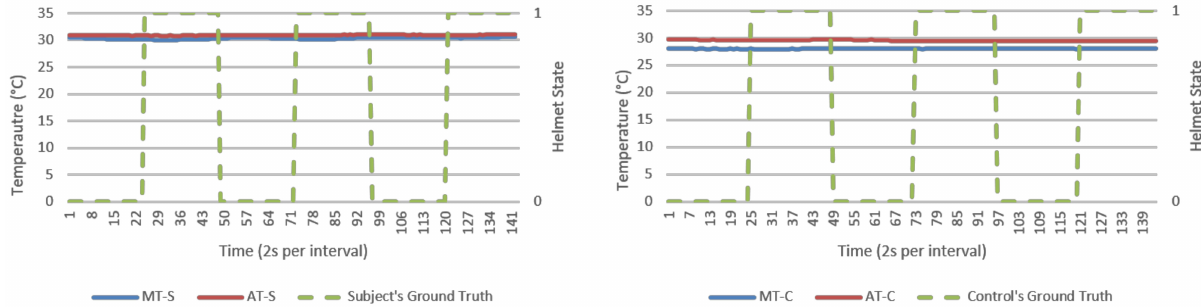
Figure 5. Temperature ( ◦ C) versus time (2 s per interval) data logs from a typical no mask (NM) run, human subject ( left ), and experiment control ( right ). Helmet state 0 = not worn (NW) and 1 = worn (W).